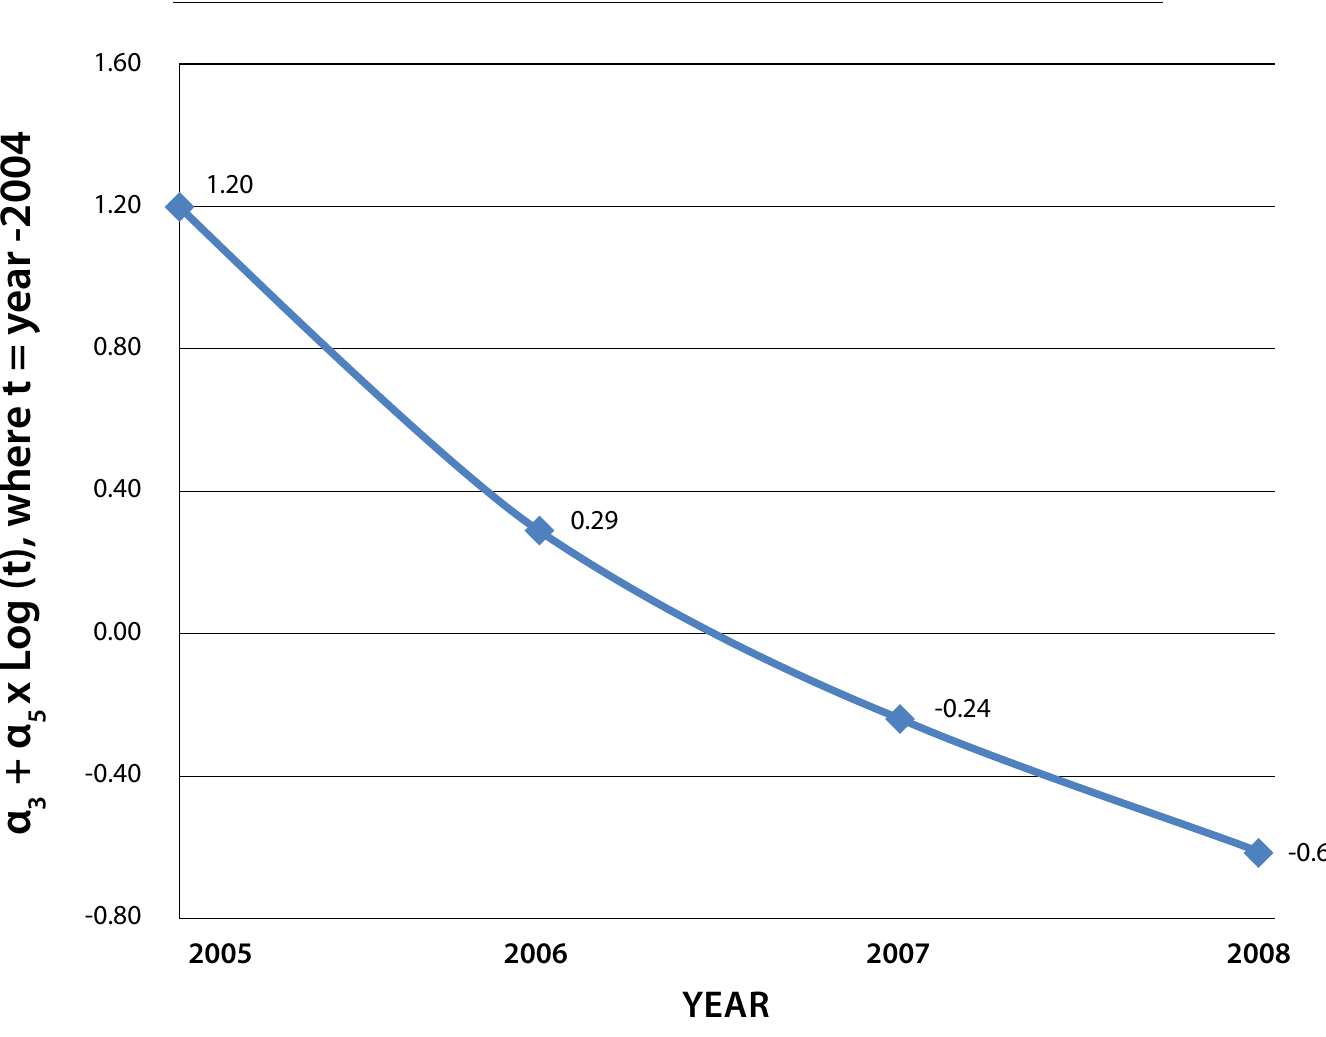
Figure 1. Diminishing effect of proactiveness on value